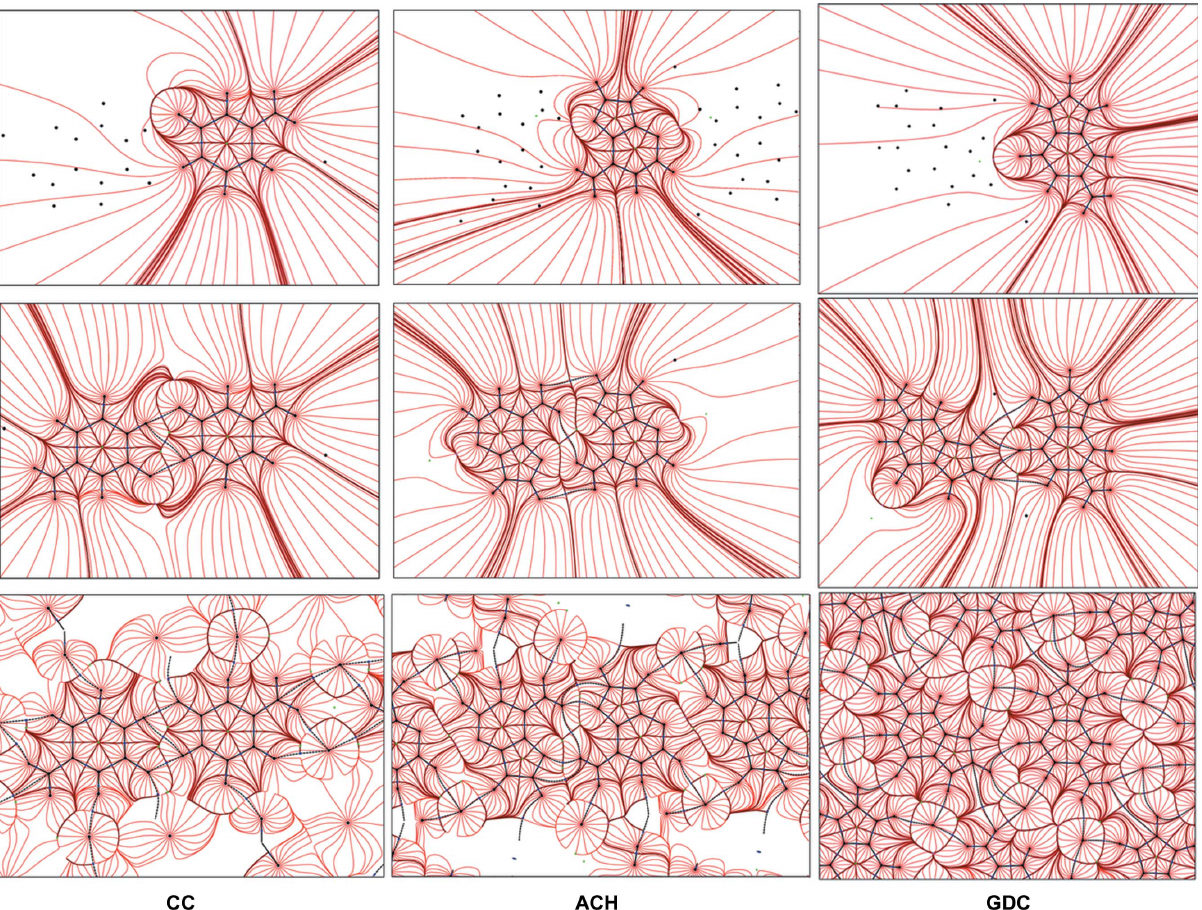
Figure 9 Gradient-field trajectory plots of the electrostatic potential of (top) nucleobases, (middle) nucleobase dimers AA1 and (bottom) entire crystals from experimental charge densities in the plane of the